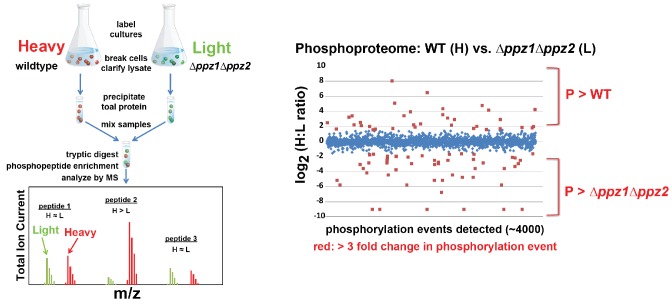
A SILAC-based quantitative comparison of the phosphoproteome in wildtype (heavy) and Δppz1Δppz2 (light) cells.The schematic on the left shows the experimental approach for quantitative analysis of the phosphoproteome in ppz mutant cells. The scatter plot on the right summarizes SILAC-based quantitative analysis of yeast phosphoproteomes comparing wildtype (heavy) and ppz mutant (light) cells. All phosphorylated peptides with a fold difference greater than three are colored red. Results of this analysis are tabulated in Figure 1—source data 1.